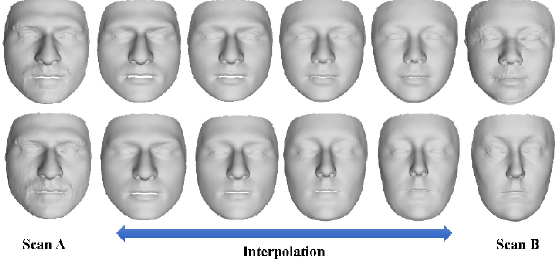
Fig. 4 On the left and right are two different scanning models. We first find their identity parameters and scale parameters. Then we perform the interpolation of the identity parameters on the hypersphere and perform linear interpolation on the scale parameter. Columns 2–5 are the result of